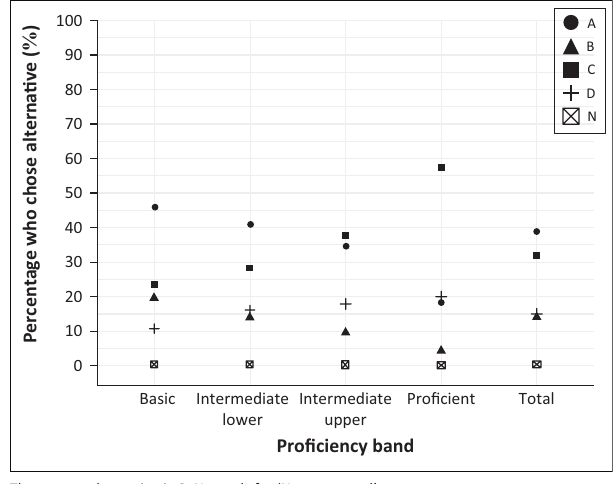
FIGURE 10: For a question requiring interpretation of a percentage in a table, the proportions of students who chose each alternative answer, for the total cohort and for each proficiency band.